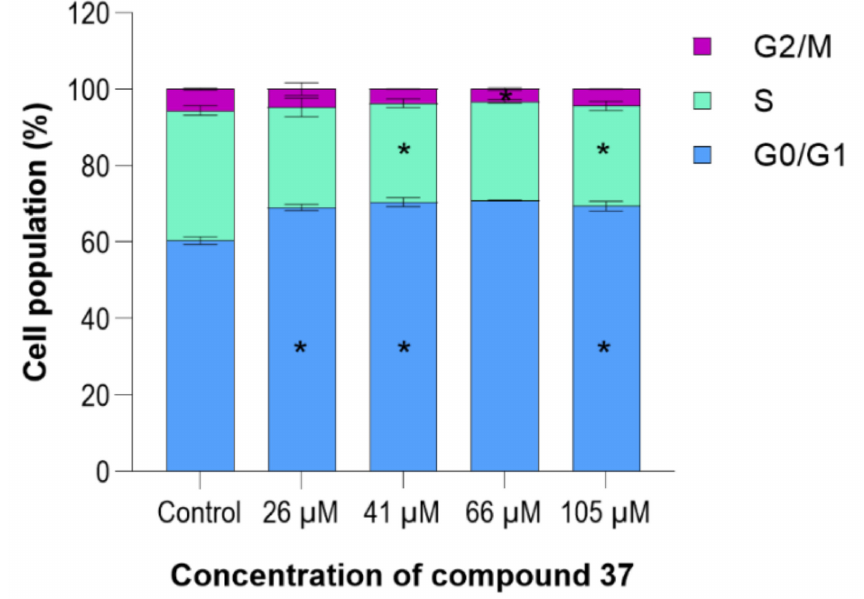
Figure 13. Cell cycle profiles for control HeLa cells and cells treated with four different concentrations of compound 37 (26 µ M, 44 µ M, 61 µ M, and 105 µ M) for 24 h. Cell cycle distribution was calculated as the percentage of cells in the G0/G1, S, and G2/M phase. Data are representative of two independent experiments and were calculated as mean ± SEM. Statistical significance was considered if * p <